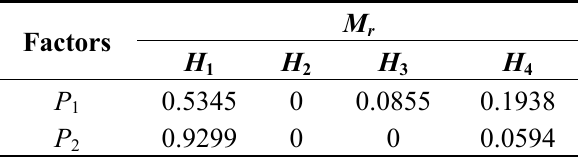
Table 7. Basic probability assignments.